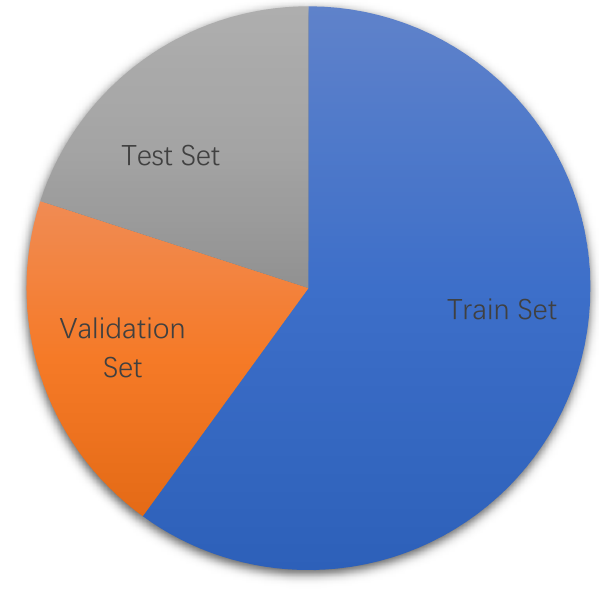
Figure 5. Data set Figure 5. Data set partitioning.